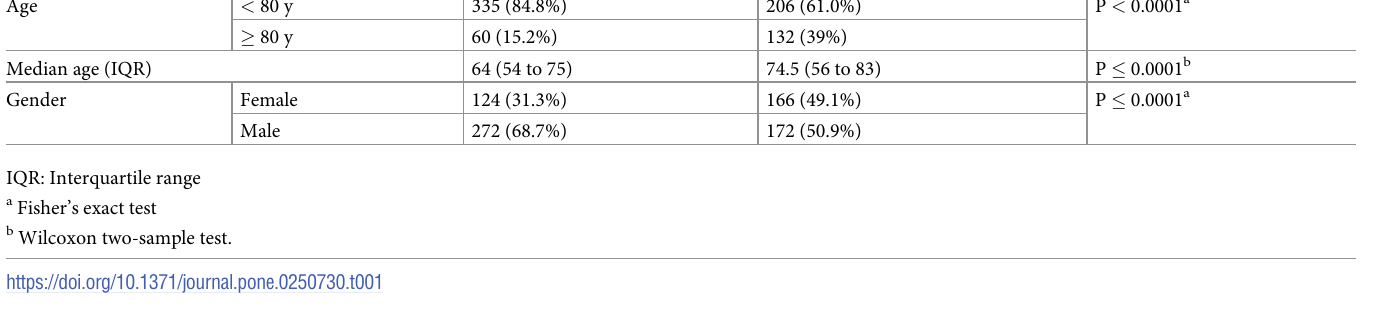
The data presented in Fig 1 show that the mortality trend over time is similar for the two age groups.